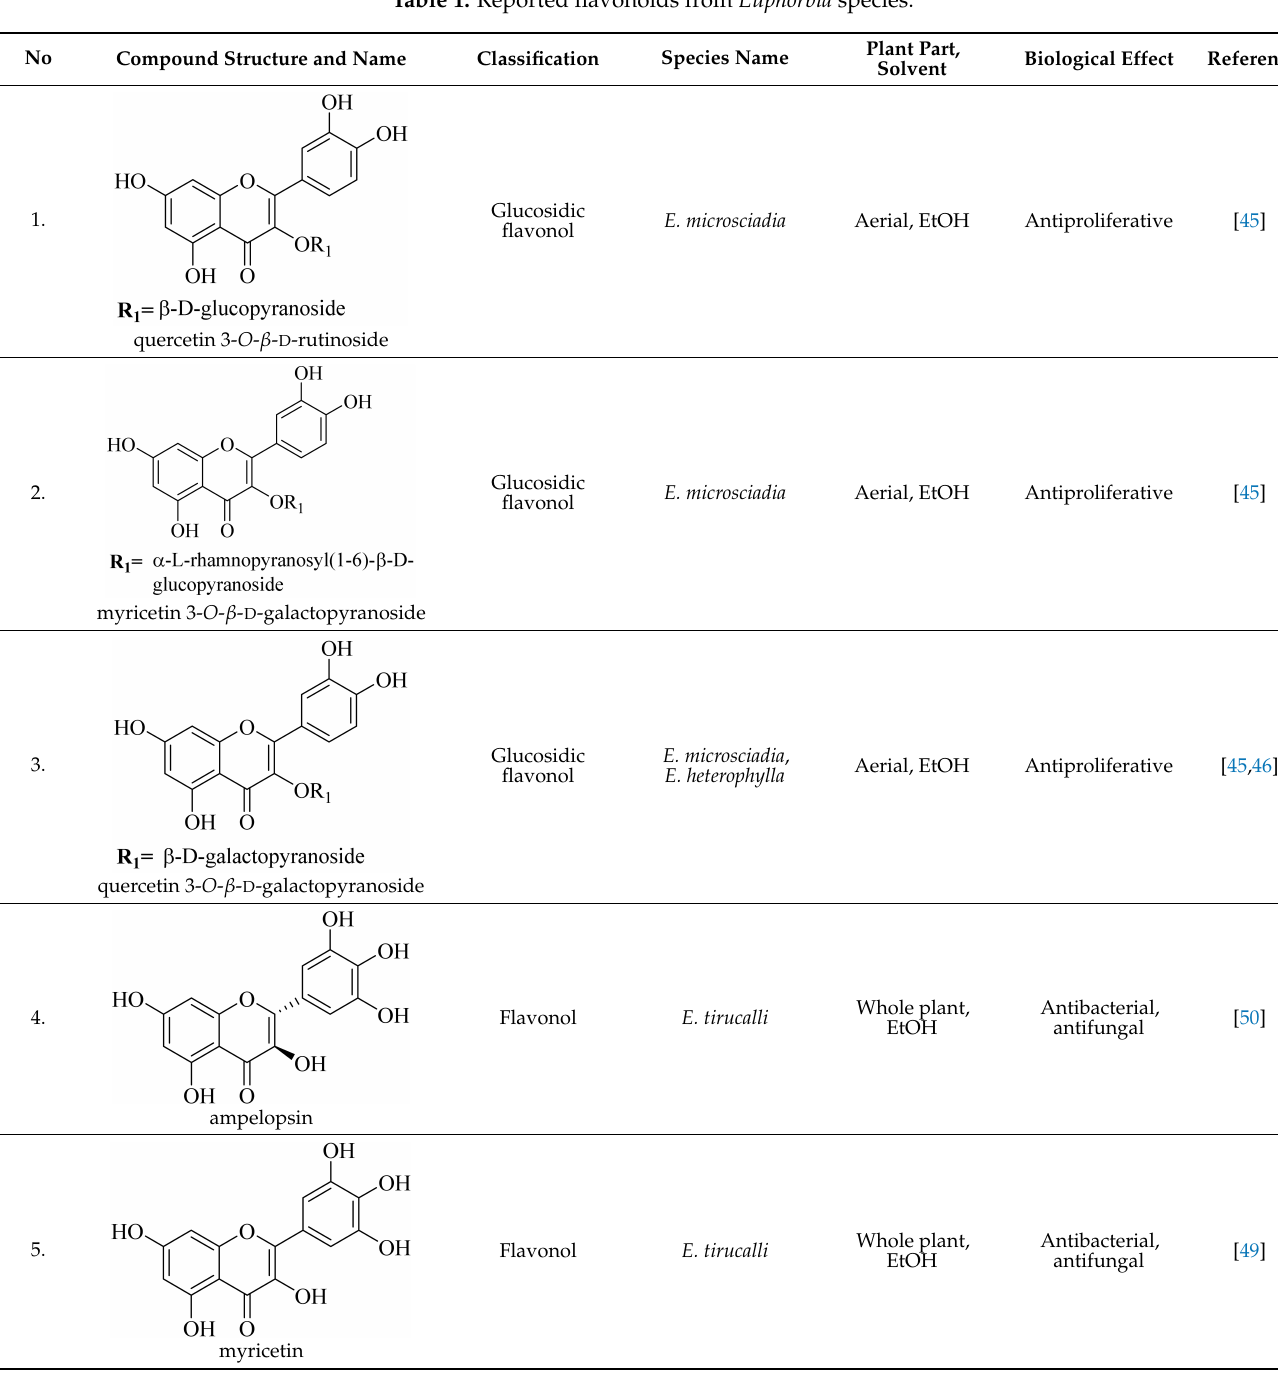
Table 1. Reported flavonoids from Euphorbia